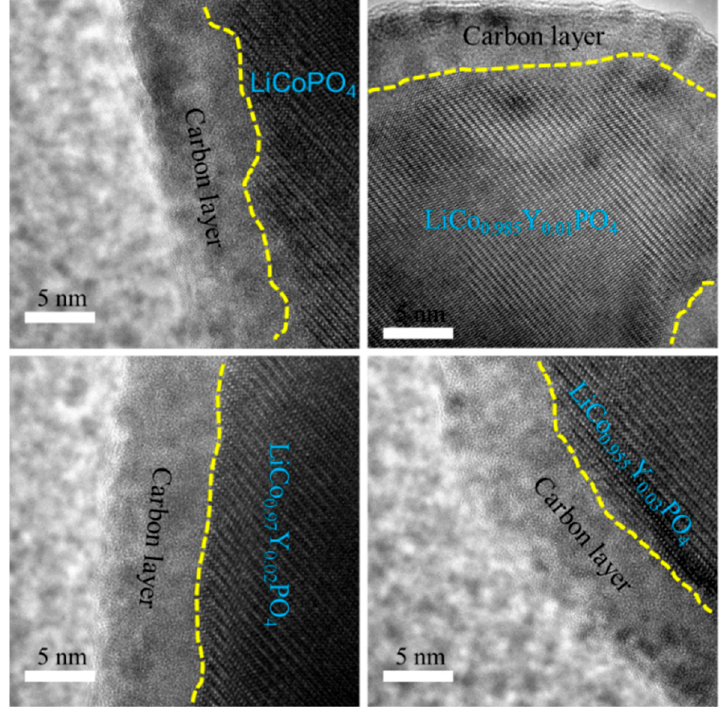
Figure 4. TEM images of the four cathode materials.